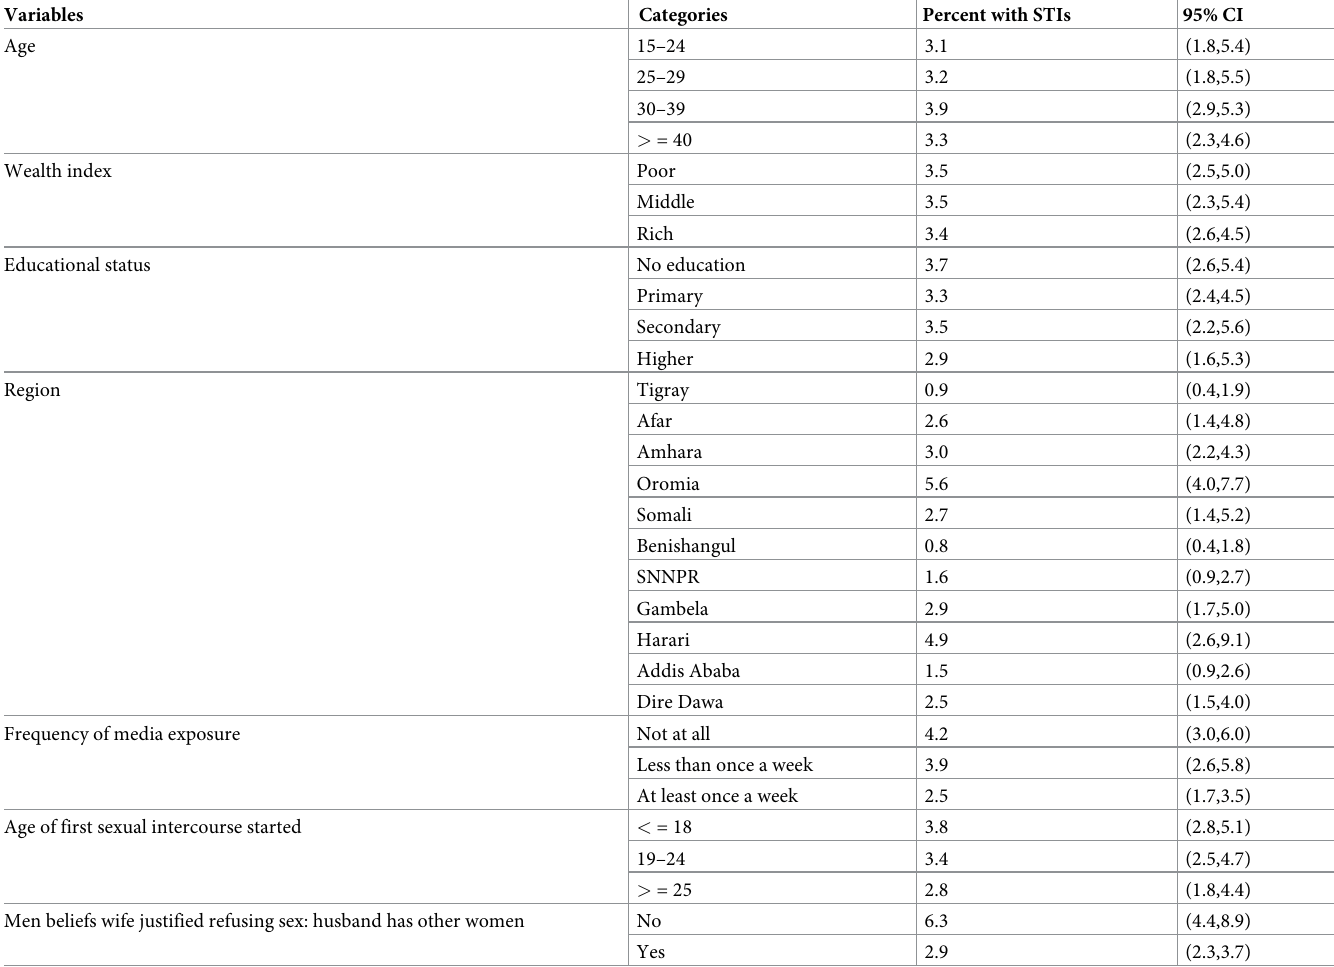
Table 3. STI prevalence by selected background characteristics among sexually active men in Ethiopia; 2016